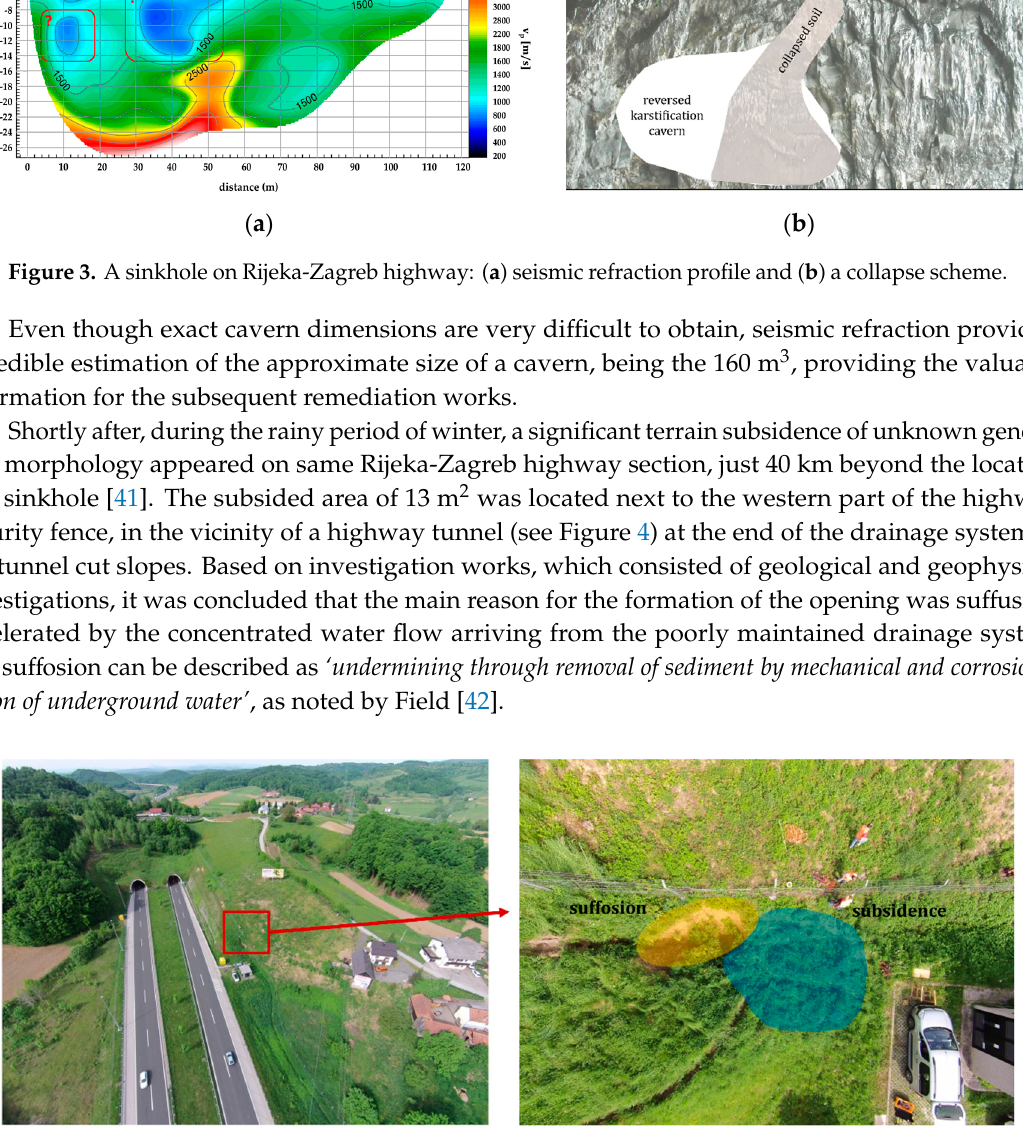
Figure 3. A sinkhole on Rijeka-Zagreb highway: ( a ) seismic refraction profile and ( b ) a collapse scheme.